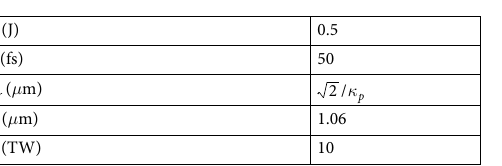
Table 3. Laser parameters. E is the laser pulse energy, τ is the beam length, σ r the beam width, λ is the laser wavelength and P is the laser peak